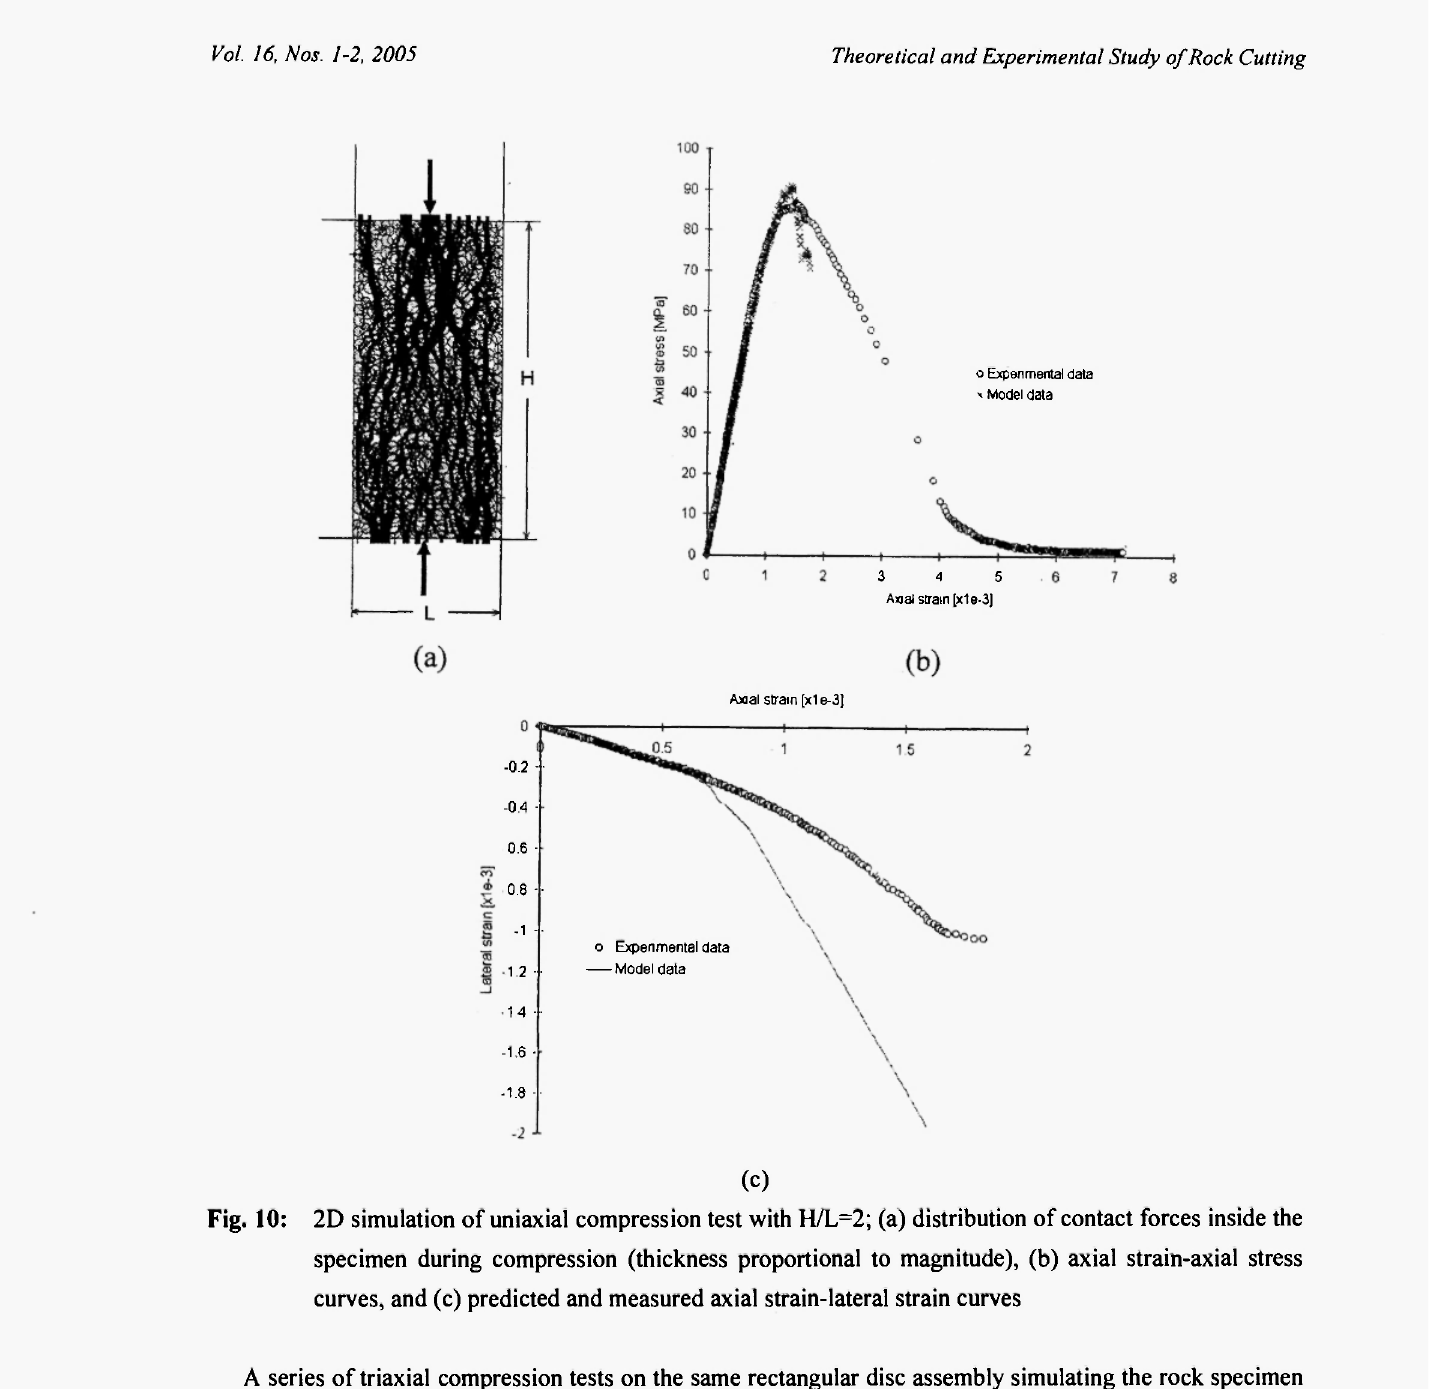
A series of triaxial compression tests on the same rectangular disc assembly simulating the rock specimen have been also simulated in order to verify that the bond strength parameters adopted in this work (Table 2) result to good comparability with experimental data. The good agreement of the model with experiments is illustrated in Fig.